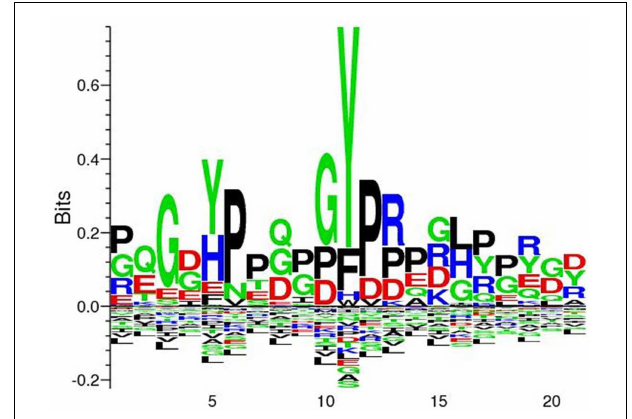
FIGURE 3 | Seq2Logo alignment analysis derived from 60kDa chaperonin revelead an overrepresentation of Tyr 358 . Seq2Logo analysis indicate that a conserved Tyr 358 − 360 is found in additional three pathogenic species, specifically Shigella spp., Klebsiella spp., and Salmonella